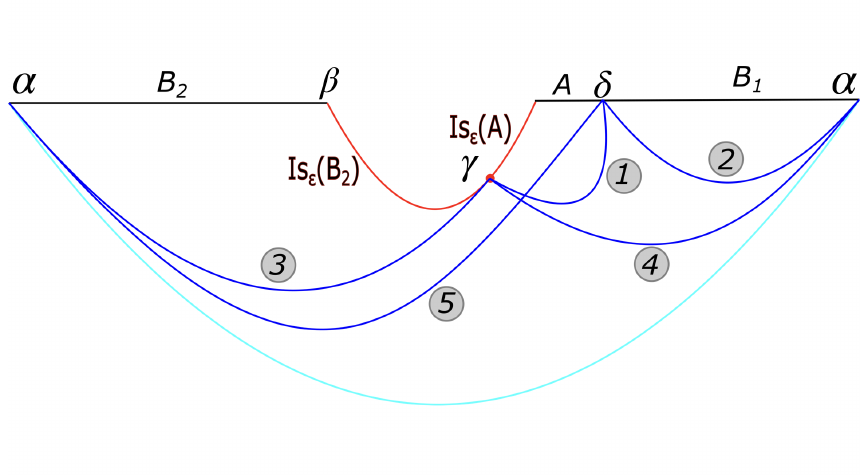
Figure 25: Schematic of the entanglement island proposal-I for the entanglement negativity of a single interval in a bath coupled to an eternal black